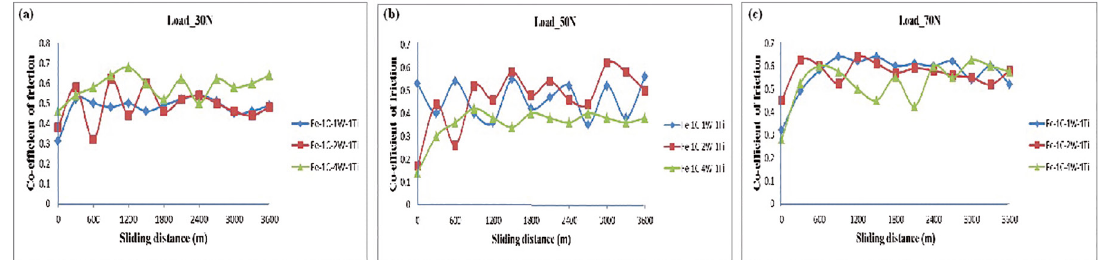
Figure 4. Variation of the frictional coefficient of hot extruded P/M low alloy steel at different loads (a) 30N; (b) 50N; (c) 70N